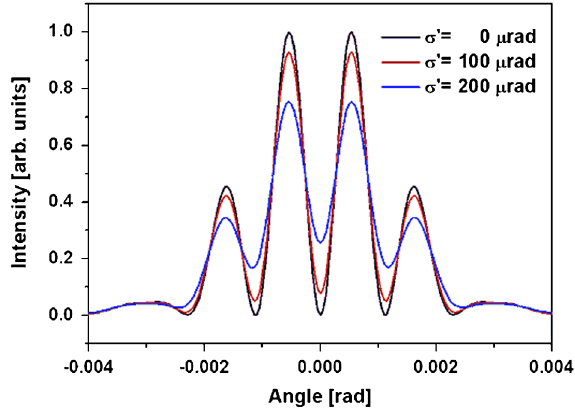
FIG. 3. Comparison between ODRI angular distribution with different values of the angular divergence for a pointlike beam passing in the center of both slits.